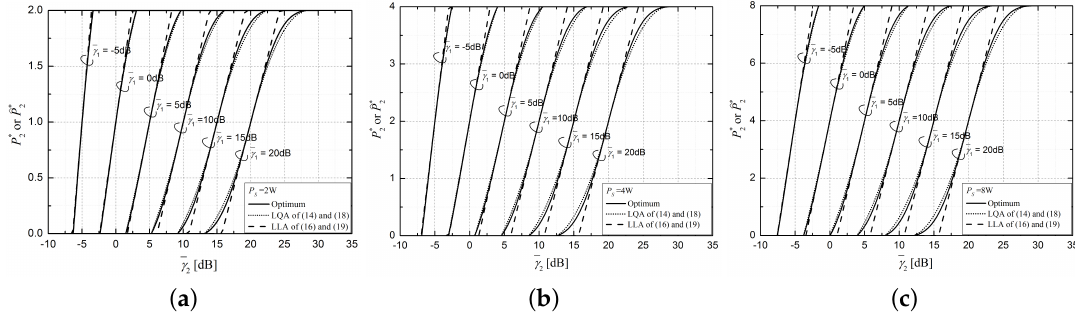
Figure 2. P ∗ versus ¯ γ 2 [dB], with ¯ γ 1 [dB] as a parameter: ( a ) P S = 2 W, ( b ) P S = 4 W, ( c ) P S = 8 2